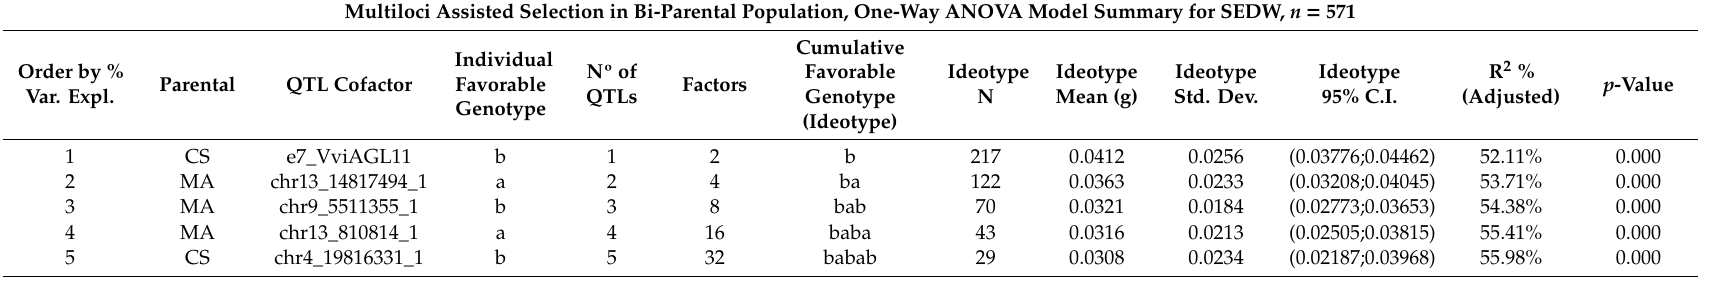
Multiloci Assisted Selection in Bi-Parental Population, One-Way ANOVA Model Summary for SEDN, n = 572